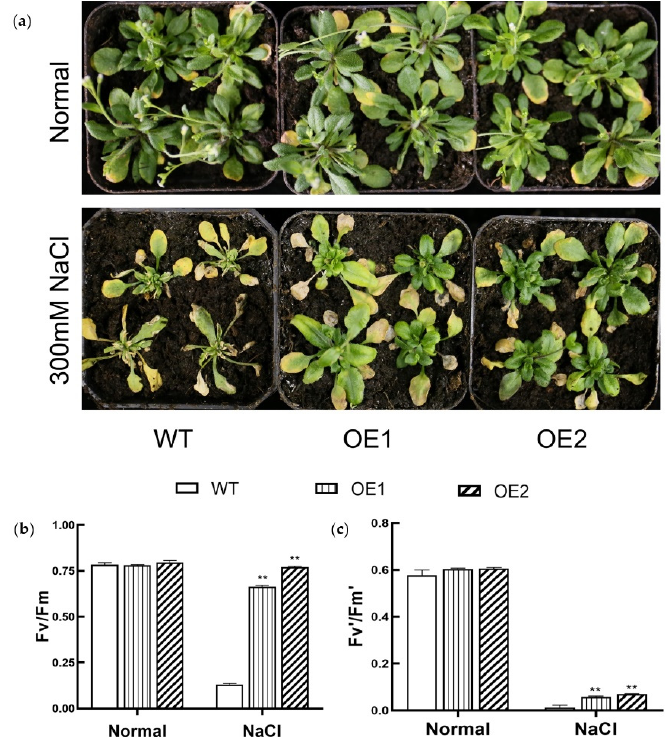
Figure 4. Responses of transgenic and WT plants grown in pots under normal and high-salinity conditions. ( a ) Morphological analysis of tested plants under different conditions. Photosynthetic characteristics of tested plants include ( b ) the maximal photochemical efficiency of photosystem II (PSII) in the dark (Fv/Fm) and ( c ) the photochemical efficiency of PSII in the light (Fv’/Fm’). Data are presented as mean ± SE ( n = 3). ** indicates a significant difference at p < 0.01.